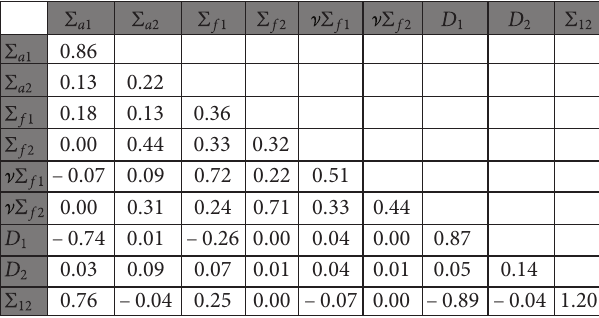
Figure 5: TMI HZP covariance matrix.